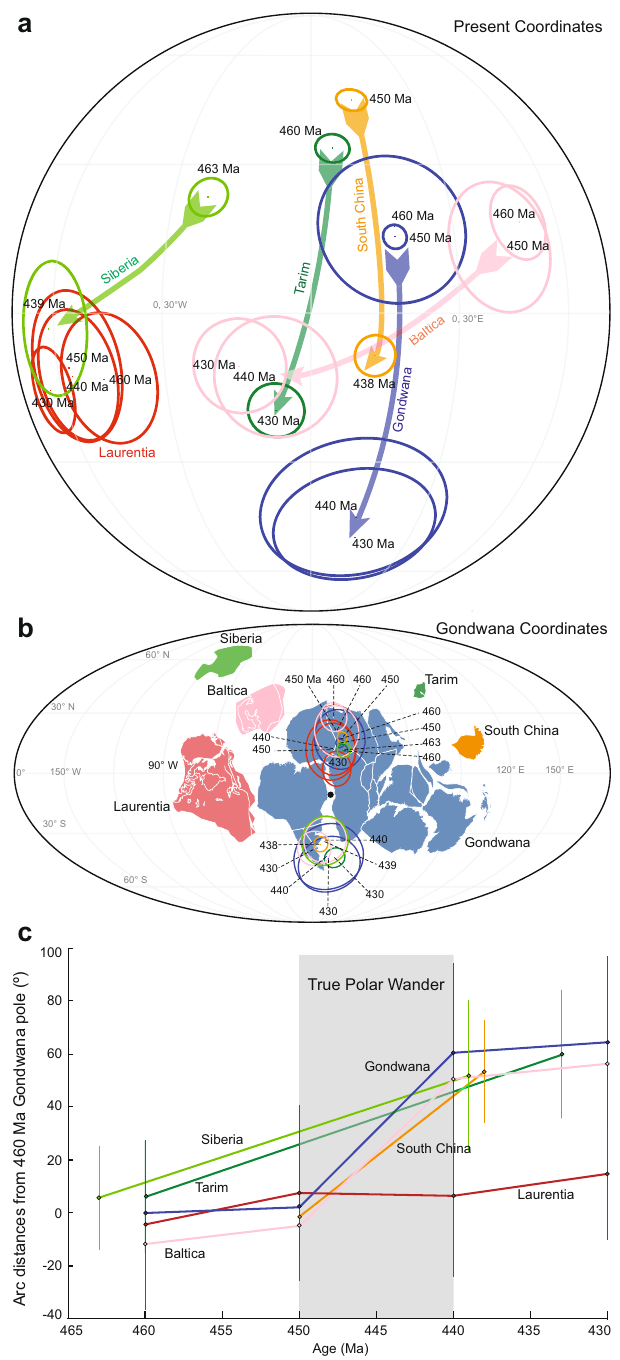
Fig. 3 | Ordovician – Silurian apparent polar wander paths globally. a Global palaeomagnetic poles for 460 – 430Ma from South China, Tarim, Siberia, Baltica, Laurentia, and Gondwana. Apparent polar wander (APW) paths all exhibit (except Laurentia) large shifts between ca. 450 – 440Ma. Poles shown in present-day coor- dinates. Pole information is listed in Supplementary Table 2. b Poles rotated into the common referenceframe ofGondwana illustrating the APW overlap. Black dot is a reference point in central Gondwana used for palaeolatitude estimates in Fig. 6e. c APW arc distances for all poles globally (in Gondwana reference frame of b )relativetothe460MaGondwanapole(asanarbitraryreferencepointbeforethe hypothesized true polar wander event). See text for discussion of Laurentia. Ver- tical bars are intervals of 95% con fi dence. Plots in a and b were generated with GPlates 73